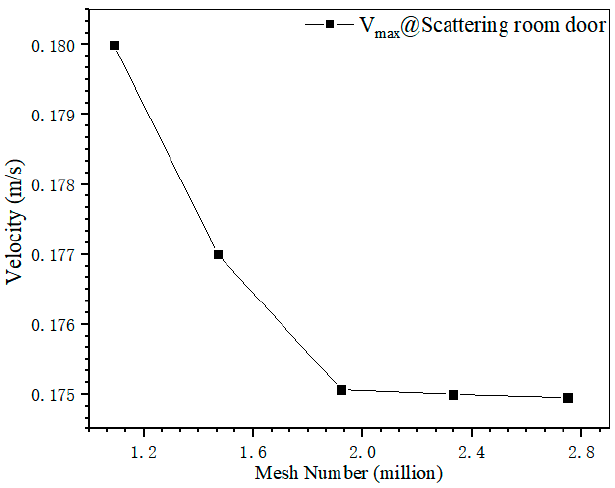
Figure 2. Meshing of computing domain. ( a ) Overall computational domain. ( b ) Local mesh of scat- tering room.